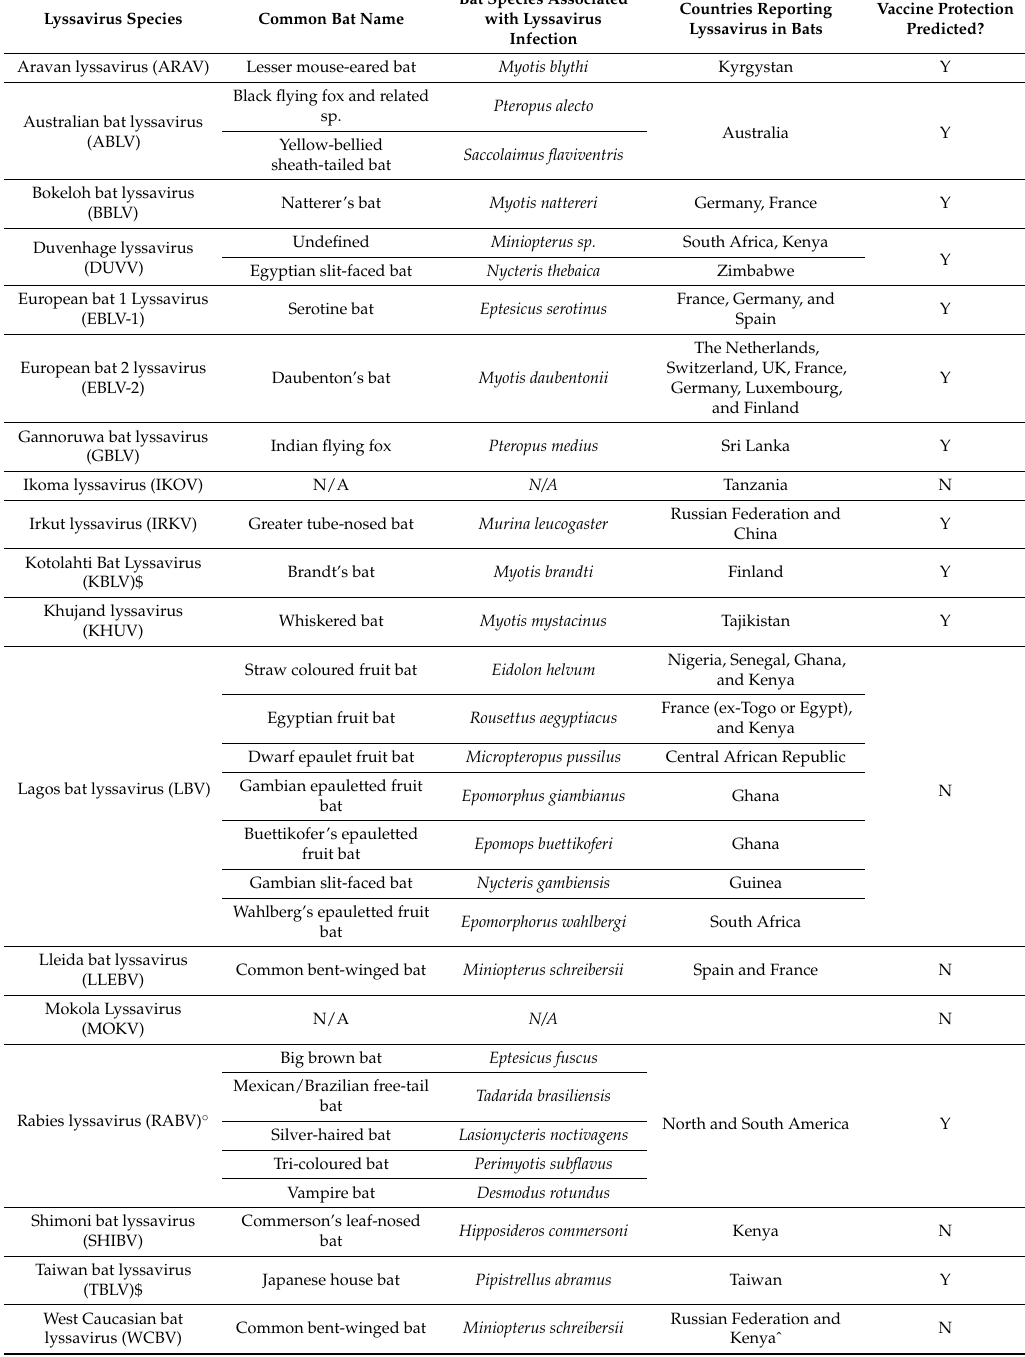
Table 1. The association of the lyssavirus species with